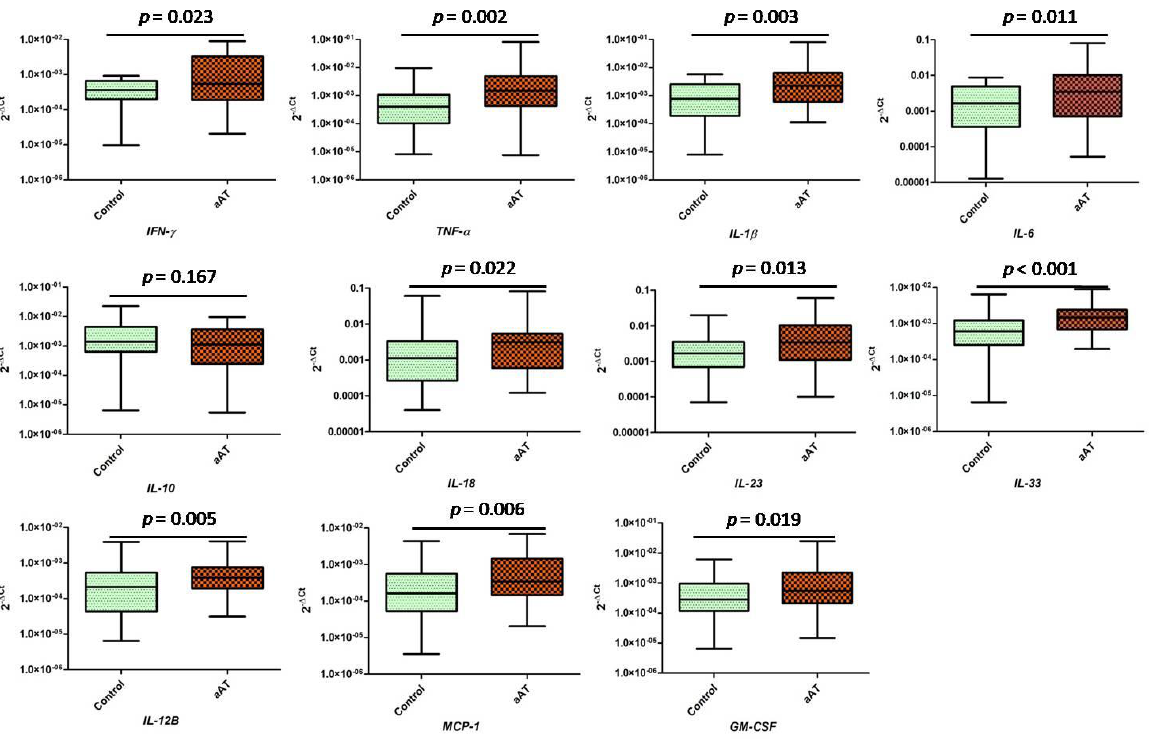
Figure 5. Expression (transcript) of atherogenic markers in the cultured macrophages after challenging with IL – 33 – primed neutrophils/NETs in the aAT patients and controls groups (IL = interleukin, MCP = monocyte chemoattractant protein /CCL – 2, GM – CSF = granulocyte macrophage colony – stimulating factor).